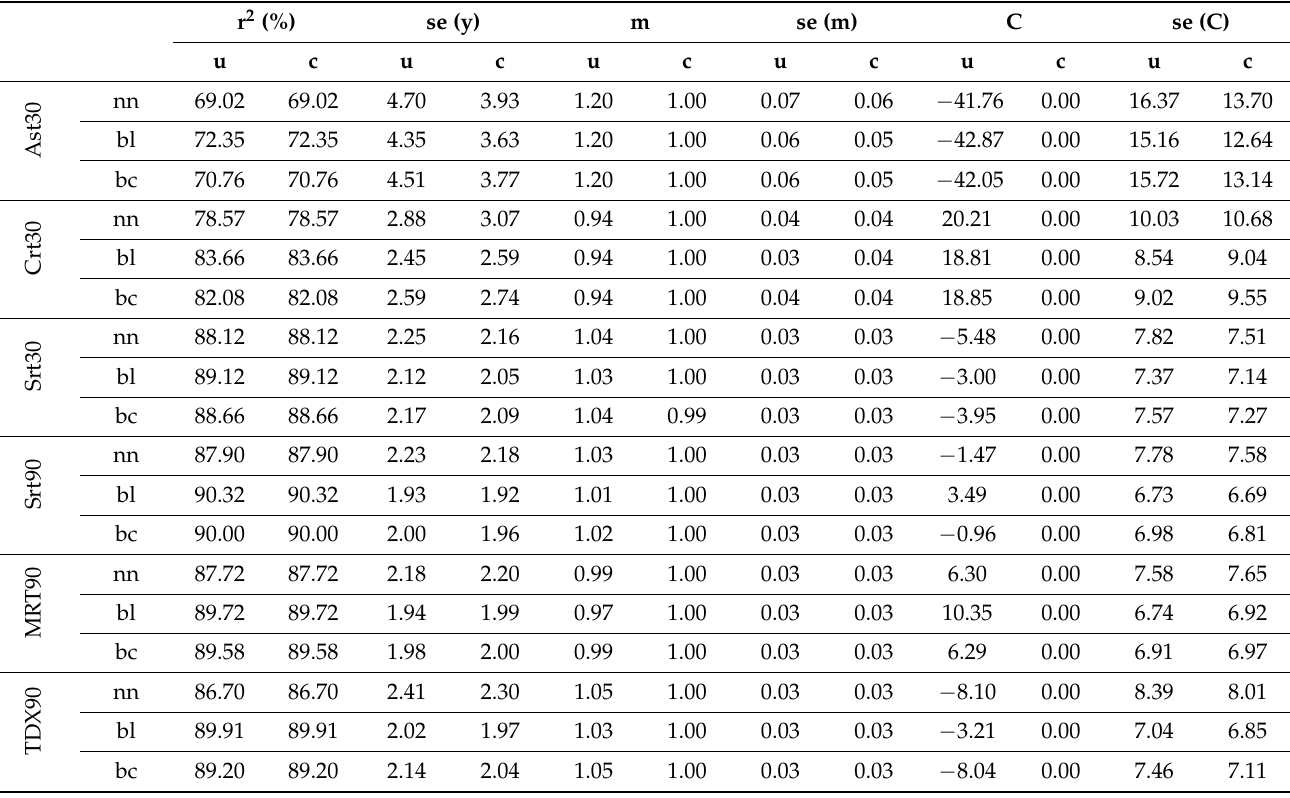
Table 11. Statistical measures of correlation established between the corrected/uncorrected elevation estimates derived from DEM and